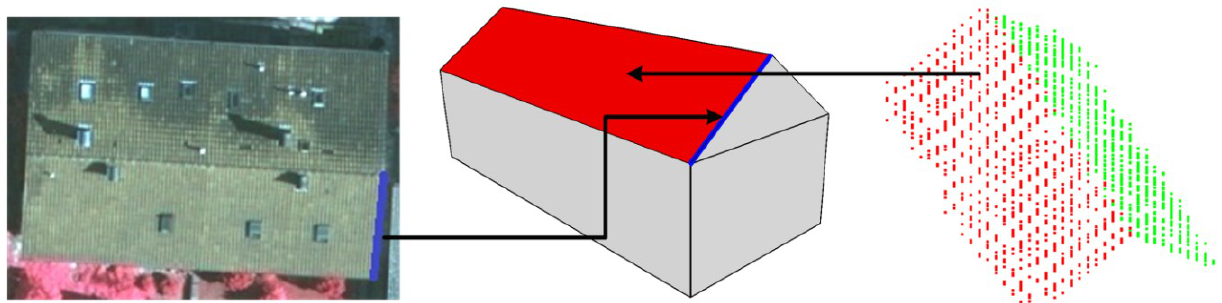
Figure 1. Primitive has sharp edges as an image and explicit surfaces as a LiDAR point cloud, and can ―glue‖ the optical imagery and LiDAR point cloud data.